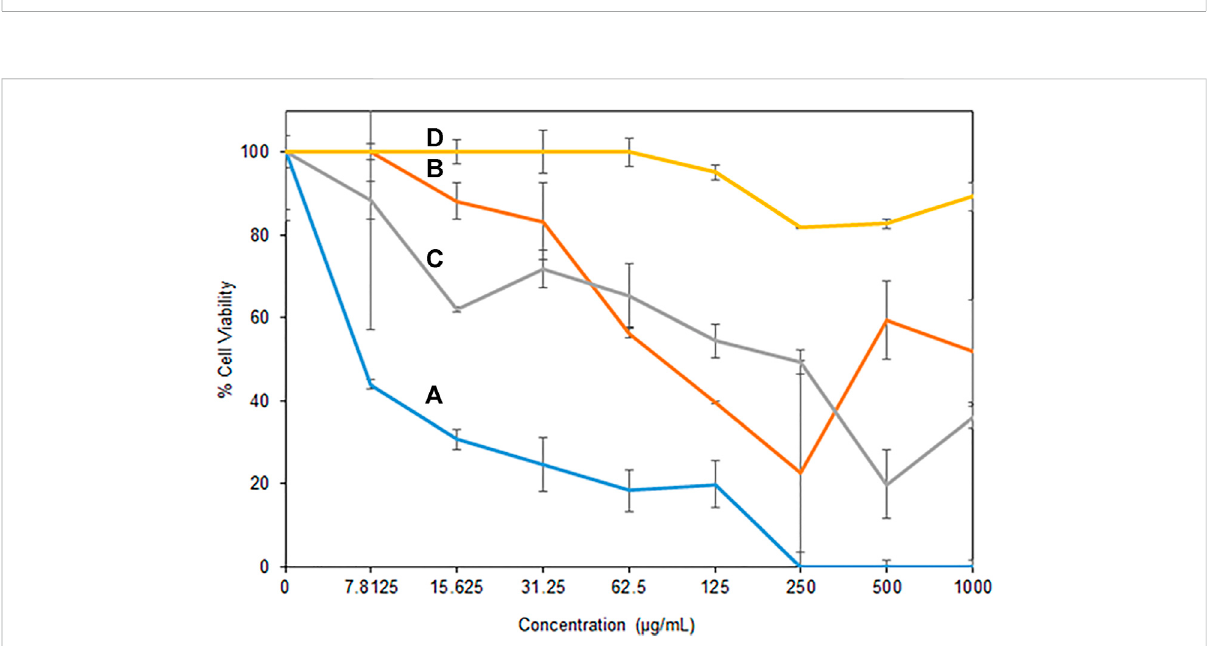
FIGURE 5 Antibacterial activity of H /Cu/RGO nanocomposite (A) E. faecalis , (B) MRSA, (C) E. coli , and (D) P. aeruginosa .